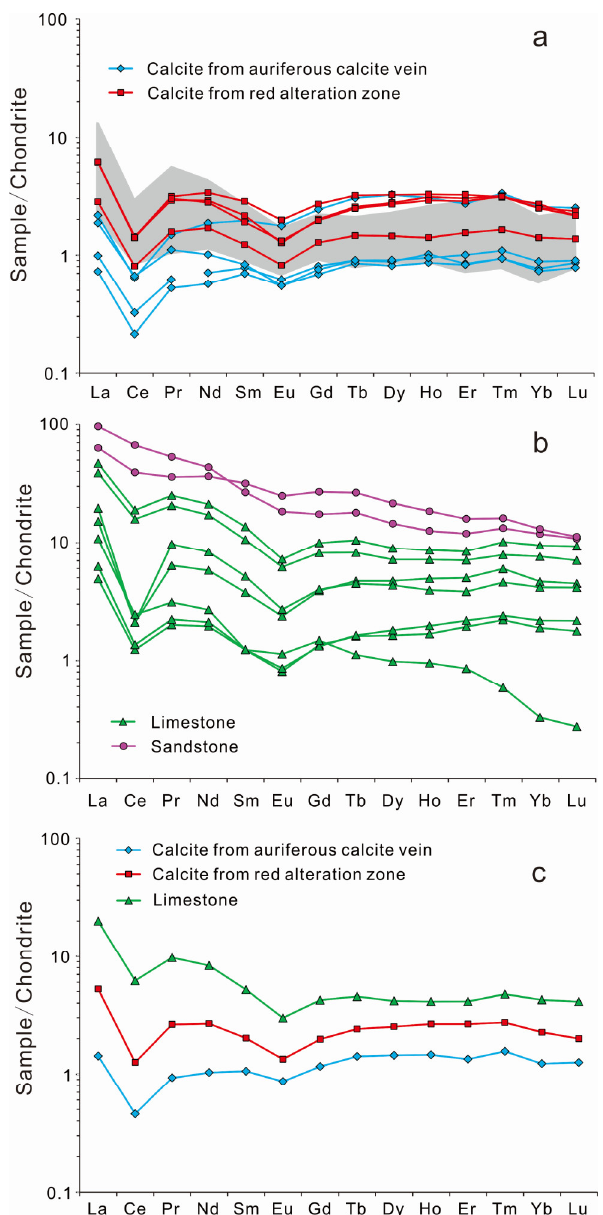
Figure 5. Rare Earth Elements (REE) distribution patterns of hydrothermal calcite and country rocks in Phapon. All samples are normalized to chondrite [50]. ( a ) Calcites respective from auriferous calcite vein and red alteration zone, shadow area referenced from [11]; ( b ) limestone and sandstone; ( c ) average value of two types of calcite and limestone.